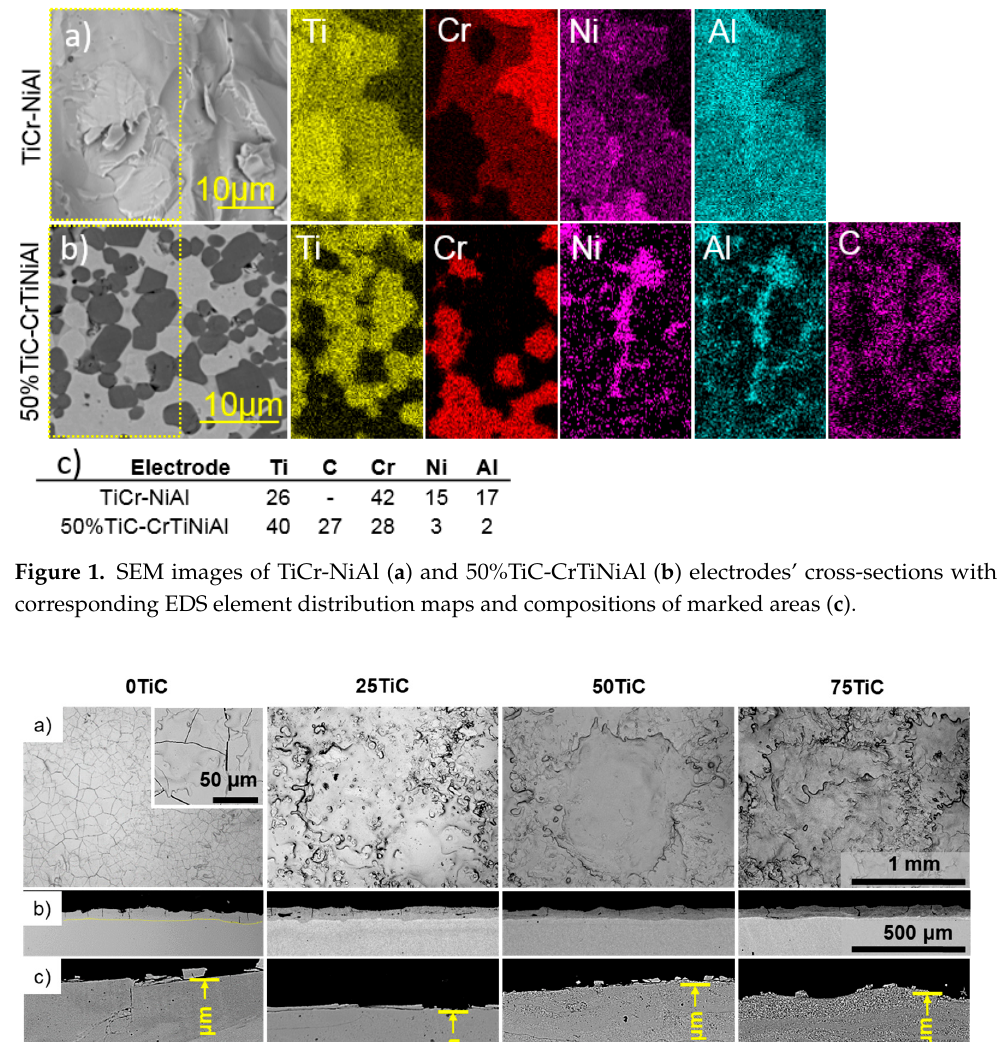
Figure 2. SEM images of surface ( a ) and cross-sections ( b , c ) of the coatings.